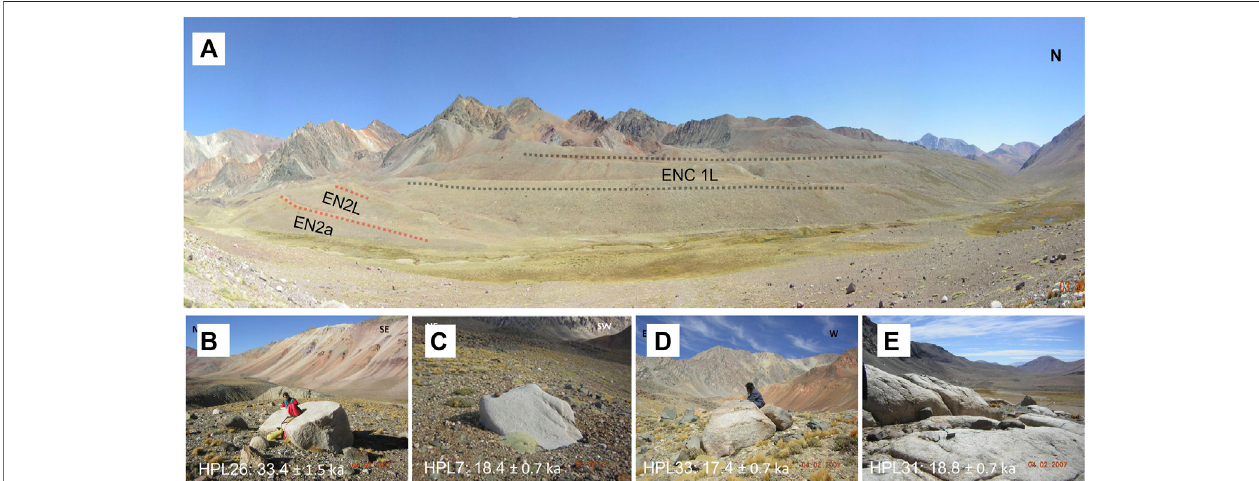
FIGURE 4 | Photographs of 10 Be sampling sectors. (A) Photograph toward the west taken from the location of sample toward the sequence of ENC 1L lateral moraines where Zech et al. (2006) dated four boulders between 17 – 24 ka (EE33, EE34, EE42 and EE51). (B) Photograph of sample HPL26 (lateral moraine of ENC 1L). (C) PhotographofsampleHPL7(recessionalmoraineENC2d). (D) PhotographofsampleHPL33(recessionalmoraineENC2d). (E) Photographofice-moldedbedrock surface of valley bottom taken in the location of sample